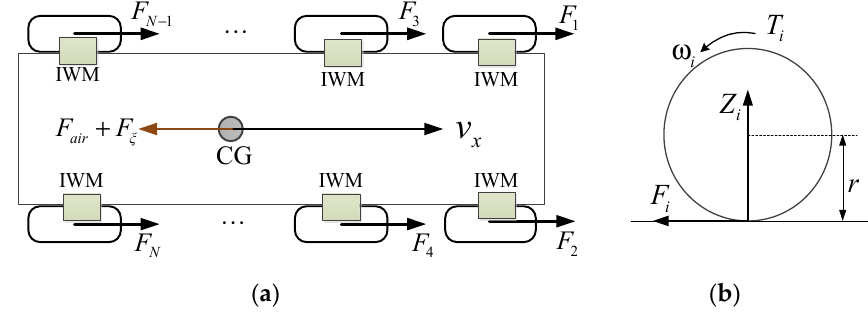
Figure 2. Longitudinal motion of IWM-EV: ( a ) Vehicle body; ( b ) Local wheel.